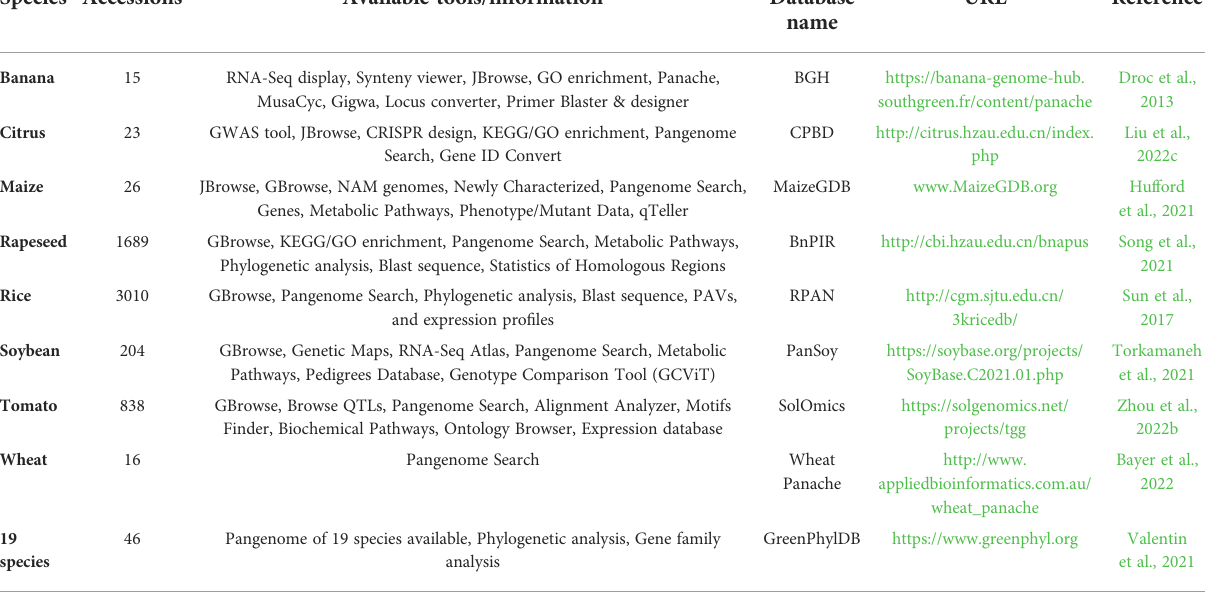
TABLE 1 List of recently available Pan-genome/integrated databases with available tools. Species